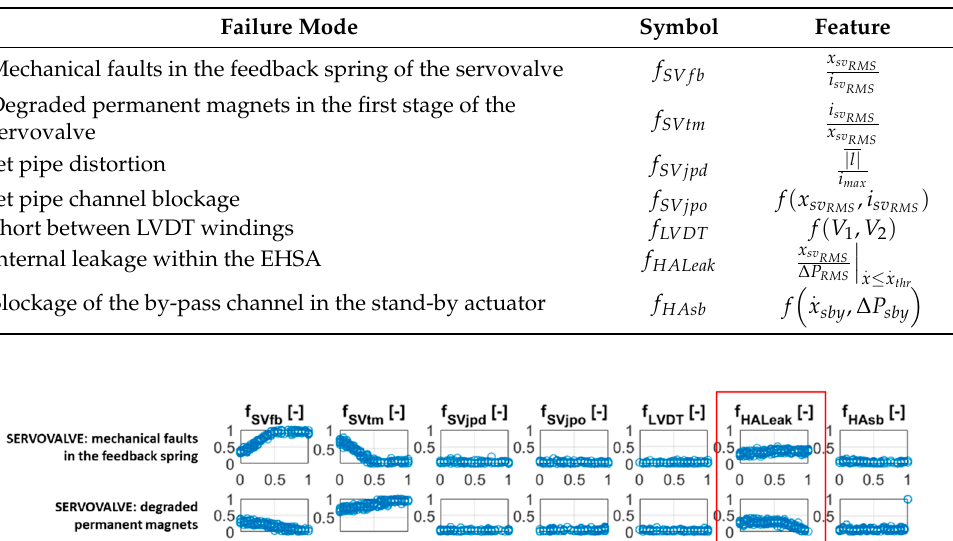
Table 1. Selected features.